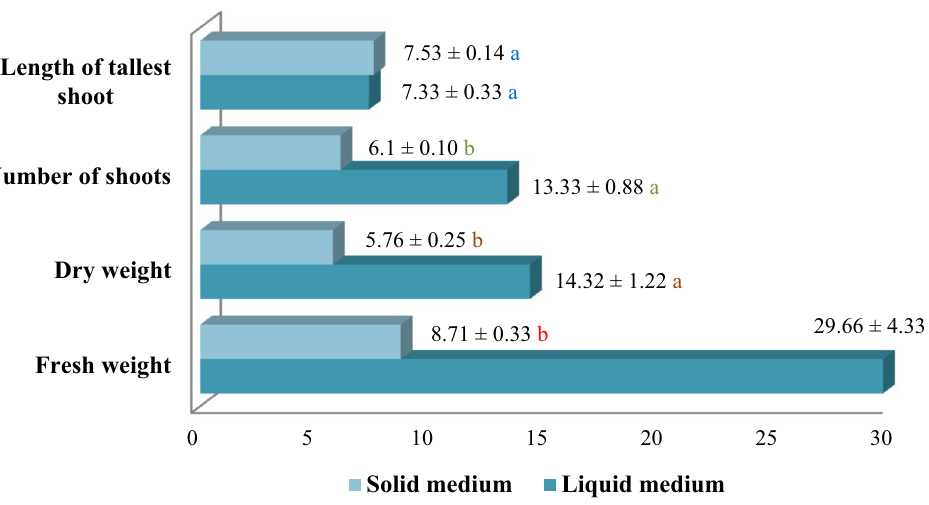
Figure 1. Comparison of in vitro growth indices of almond (shahroodi) in solid and liquid MS medium containing 1 mg/L BAP + 0.01 mg/L IBA + 0.5 mg/L GA3. (n = 3, p < 0.01, ± S.E).